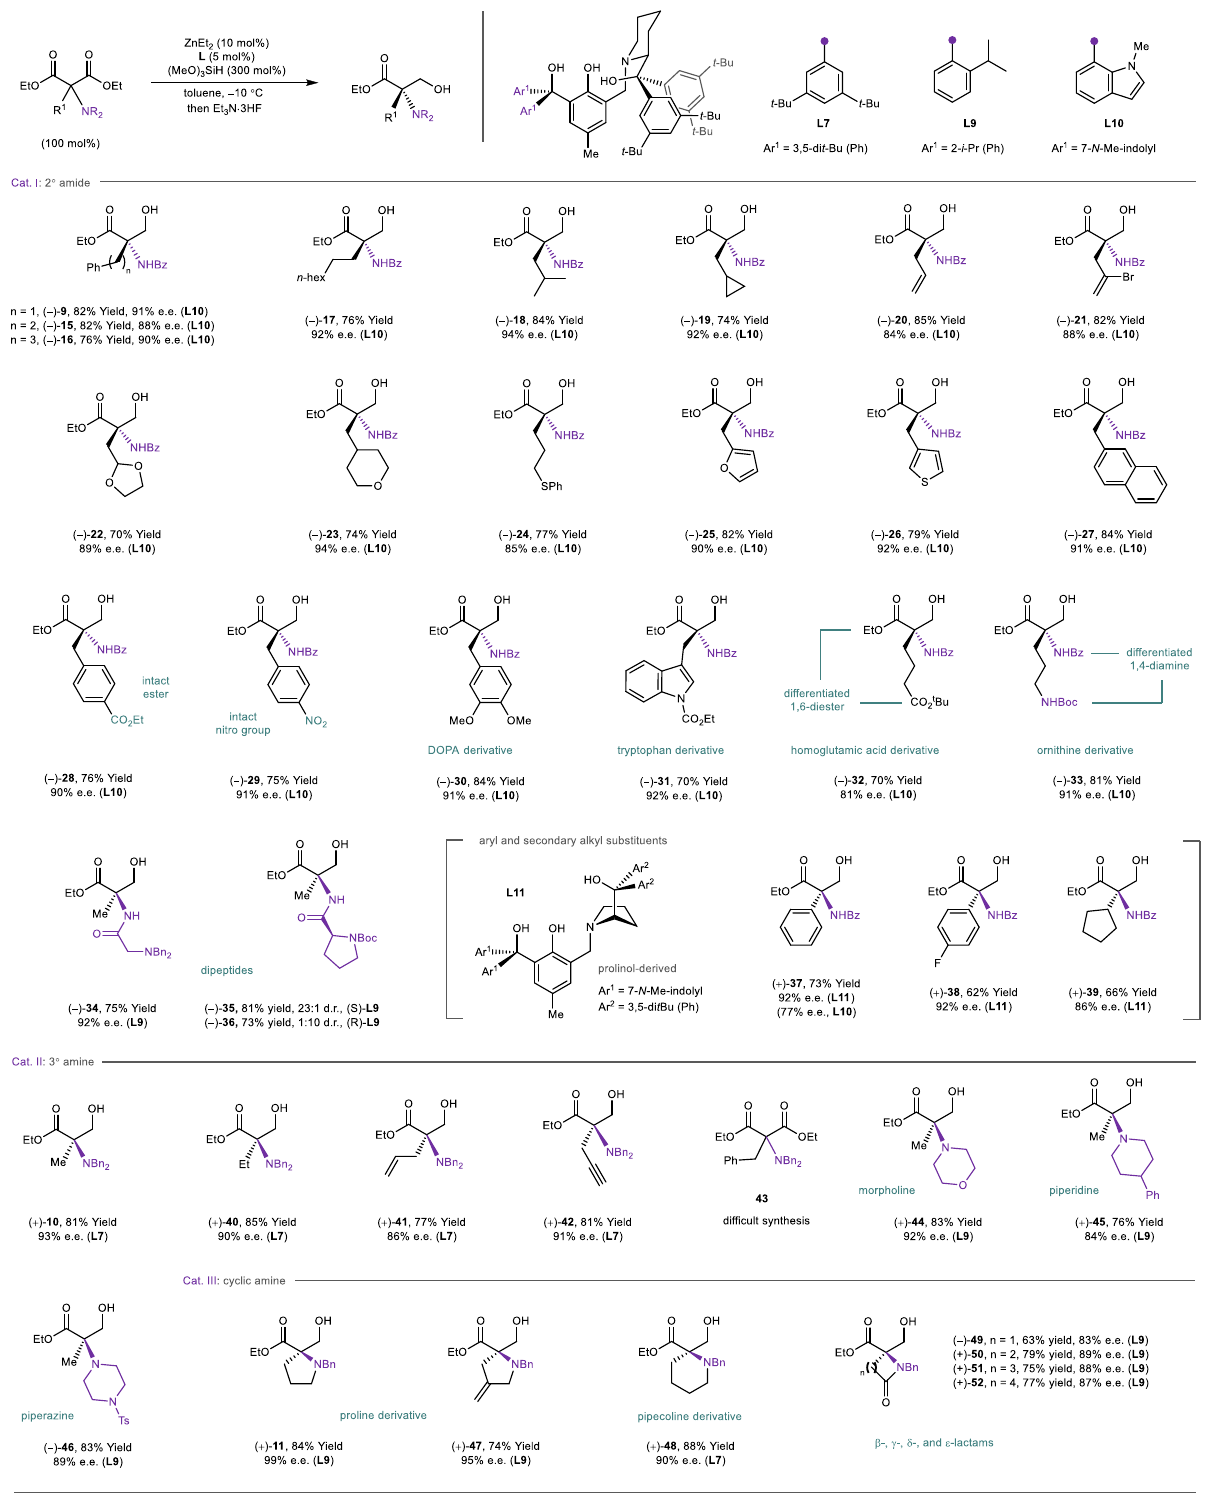
− 10°C. The yields shown were isolated yields and e.e. values were determined by chiral HPLC analysis of isolated products. The d.r. values of 35 and 36 were determined by crude NMR. d.r. diastereomeric